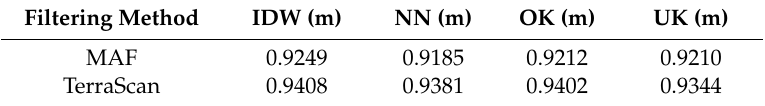
Figure 7. Filtering effect of a sample in Dayekou area. ( a ) DSM; ( b ) digital elevation model (DEM) generated from filtering results. Table 4. Elevation root mean square error (RMSE) comparison of Dayekou data filtered by MAF and TerraScan. IDW: inverse distance weight, NN: nearest neighbor, OK: ordinary kriging, UK: universal kriging.